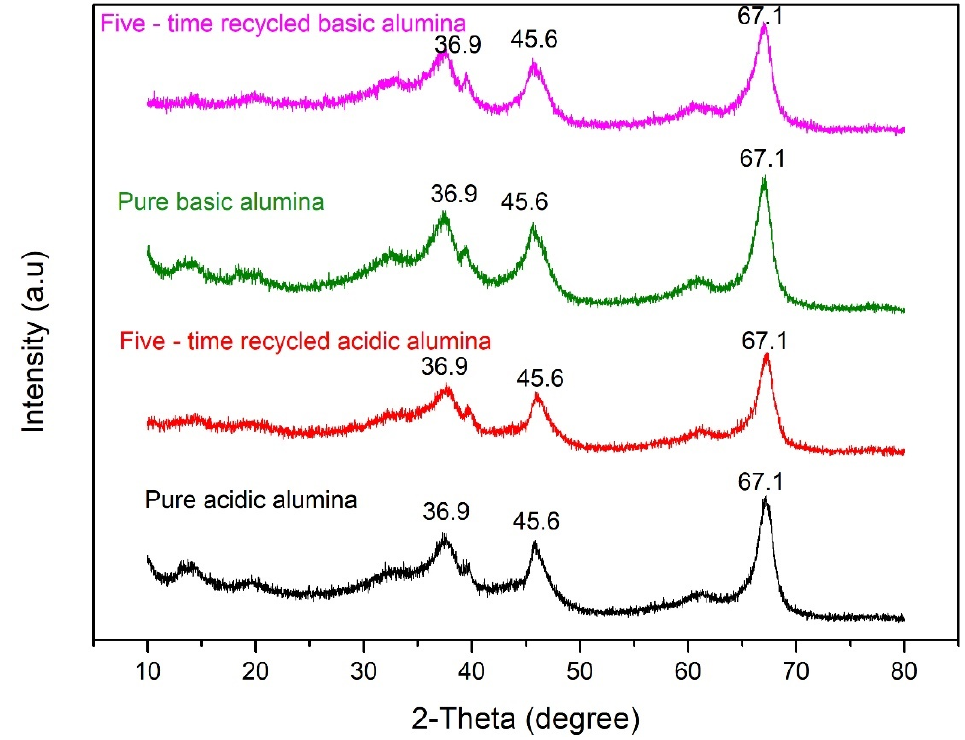
Figure 2. XRD patterns of pristine alumina (acidic and basic) and after five-time thermal regenera-